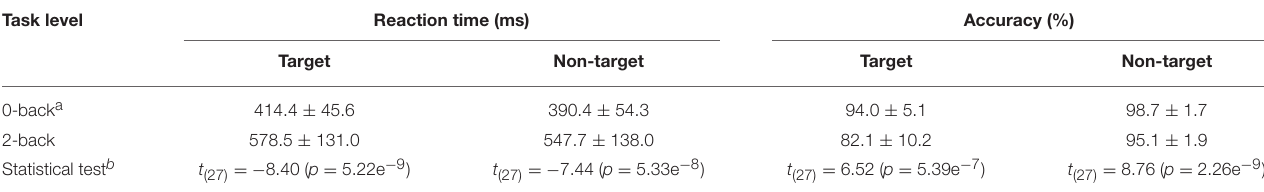
TABLE 1 | Behavioral results of the 0-back and 2-back